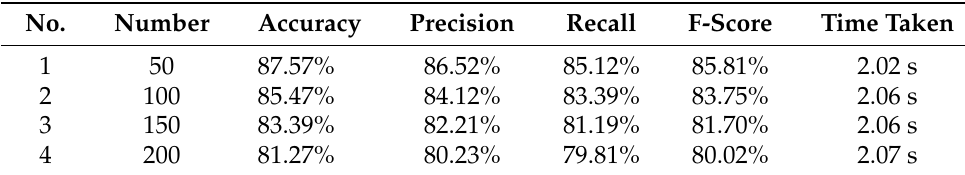
Table 7. Command type e Experimental results.